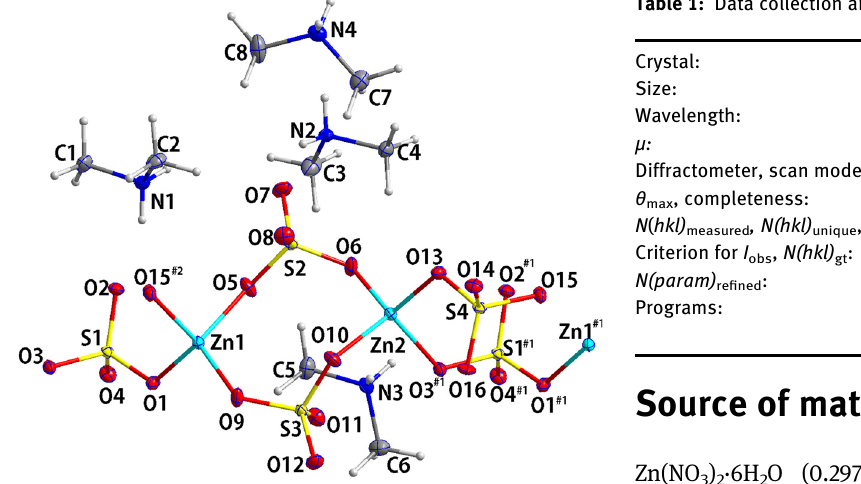
Table  : Data collection and